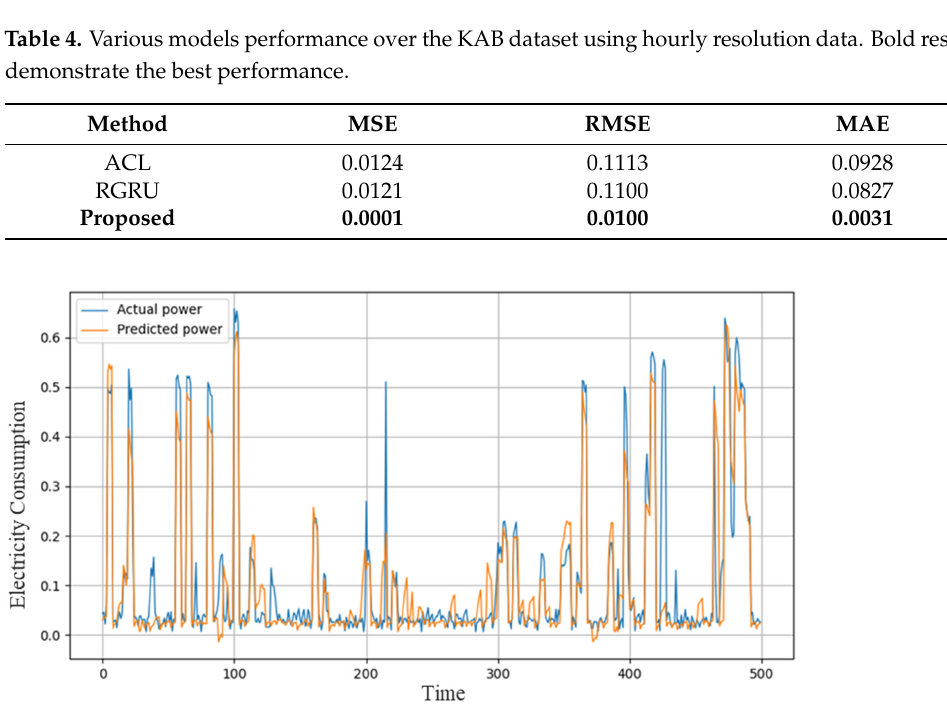
Figure 7. Performance of the proposed model over IHEPC dataset.